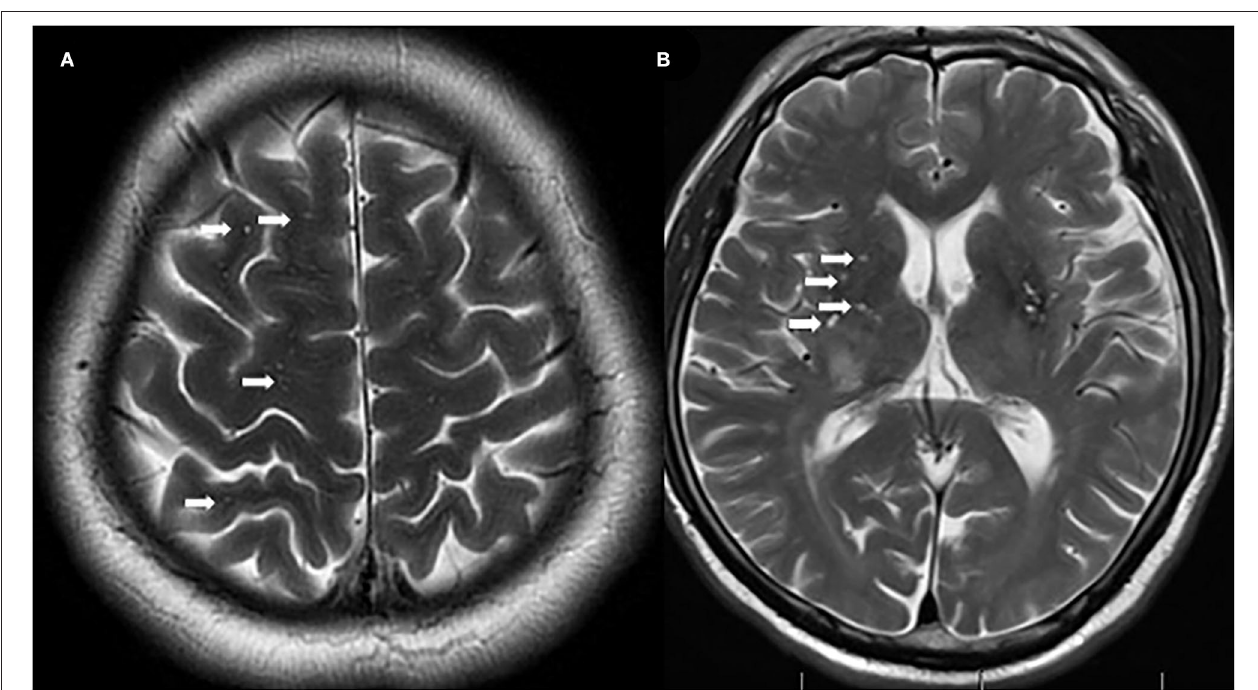
FIGURE 2 | Representative examples of centrum semiovale-enlarged perivascular spaces (CS-EPVS) (A) and basal ganglia (BG)-EPVS (B) . Arrowheads point to individual EPVS. EPVS, enlarged perivascular spaces; BG, basal ganglia; CS, centrum